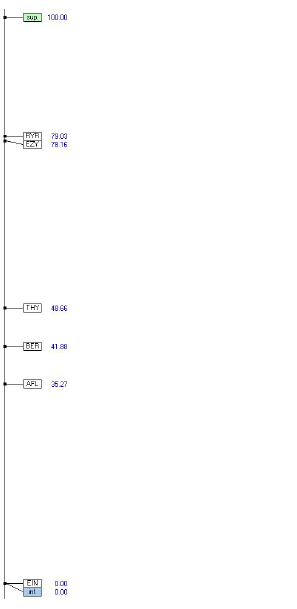
Figure 15: Global Thermometer: Busi- ness.